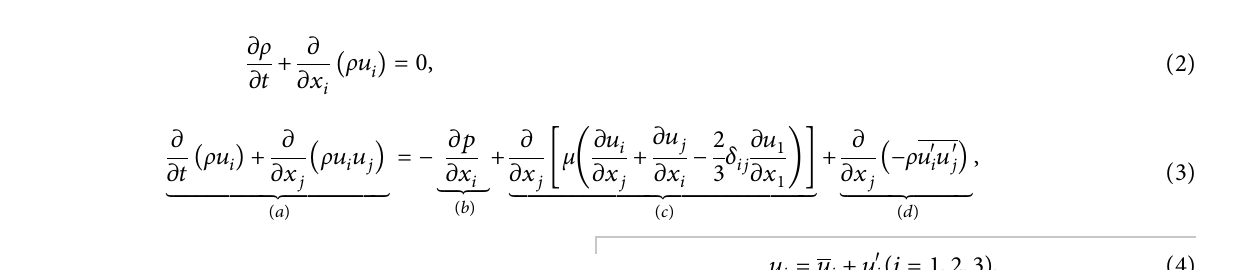
Table 1 is the components of the flapping wing